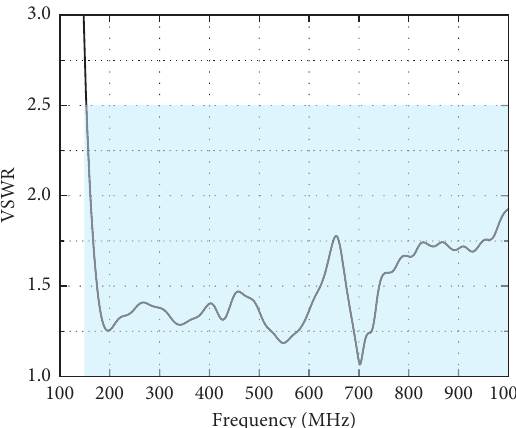
Figure 5: VSWR of combined time-domain antenna.